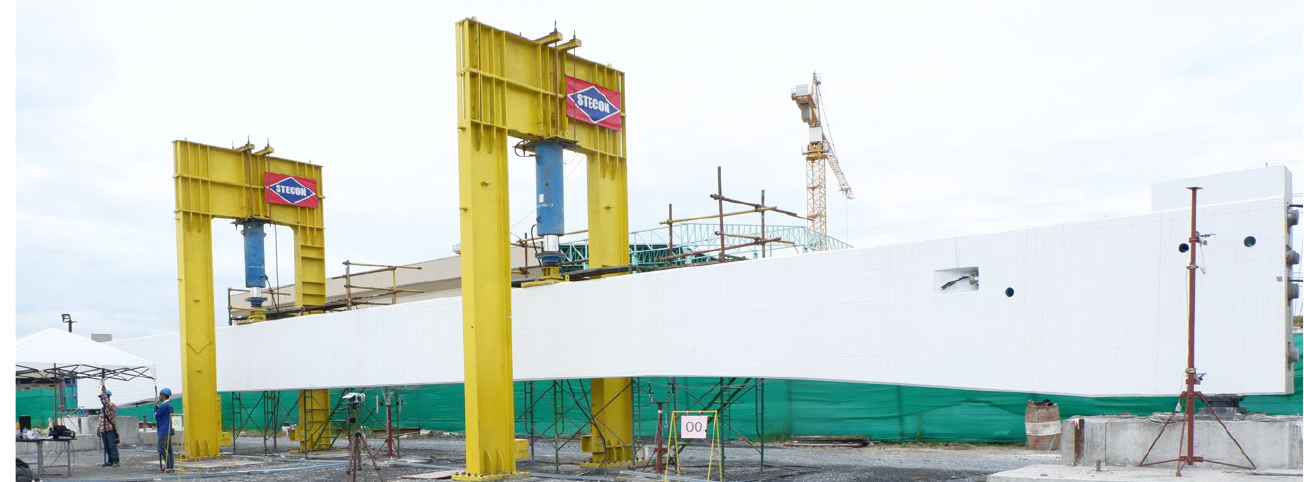
Figure 14. The two-point load applied to specimen SP-02.